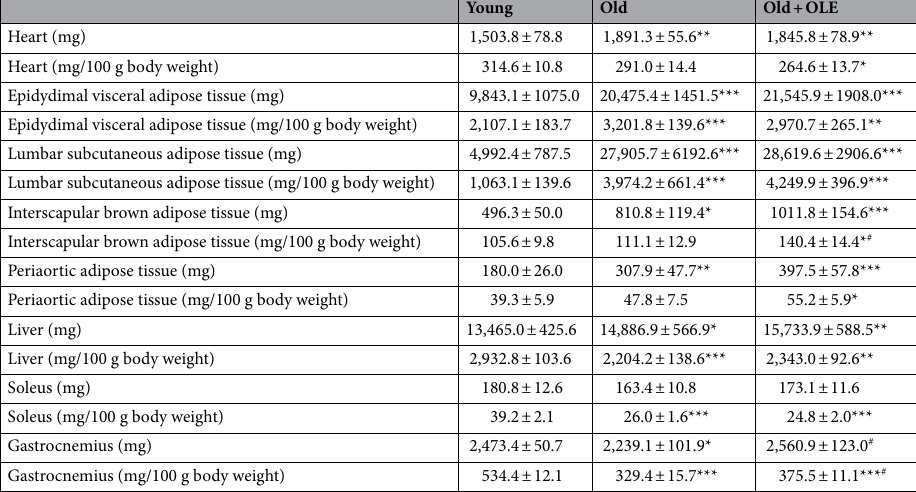
Table 2. Organ weights of young rats, old rats and old rats treated with olive leaves extract (OLE). Data are represented as mean value ± SEM; n = 6–11 samples/group. * p < 0.05 vs. Young; ** p < 0.01 vs. Young; *** p < 0.001 vs. Young; # p < 0.05 vs. Old.